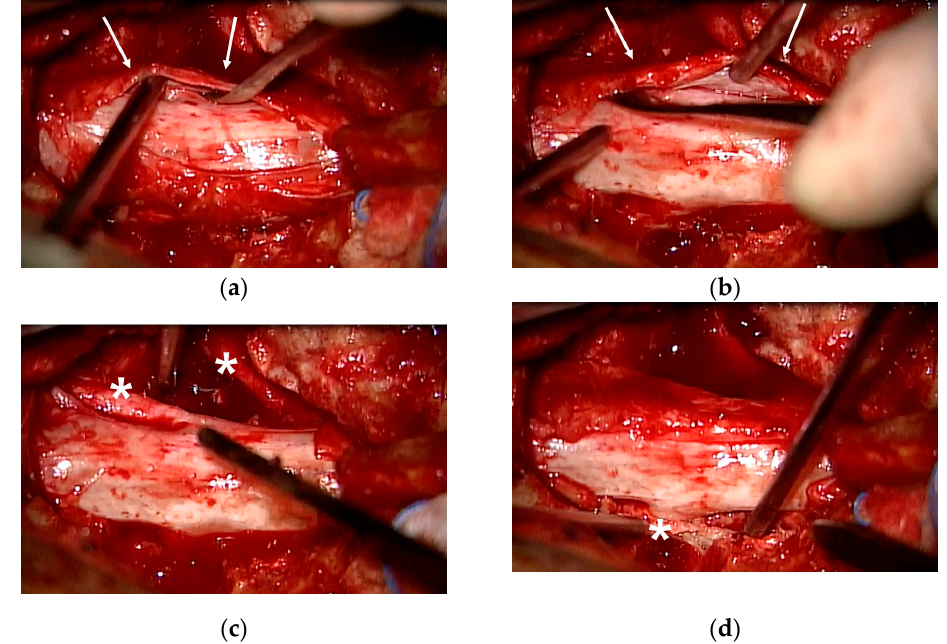
Figure 3. ( a , b ) Revision surgery revealed severe epidural fibrosis along the thecal sac and L5–S1 roots. Normal dura was identified following thick epidural fibrosis peeling (arrows). ( c , d ) Bilateral lumbosacral roots (asterisks) were identified and released by fibrotic membrane removal.